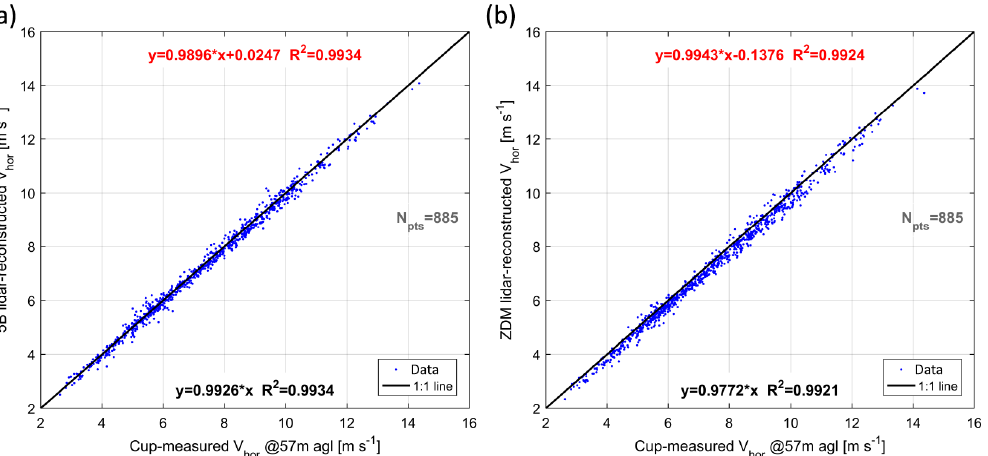
Figure 10. Comparison between mast-measured and lidar-estimated horizontal wind speed at 57.5m height a.g.l and 2 . 5 D rot using short- range measurements. (a) 5B-Demo lidar, using five LOS and four ranges. (b) ZDM lidar, using six LOS and three